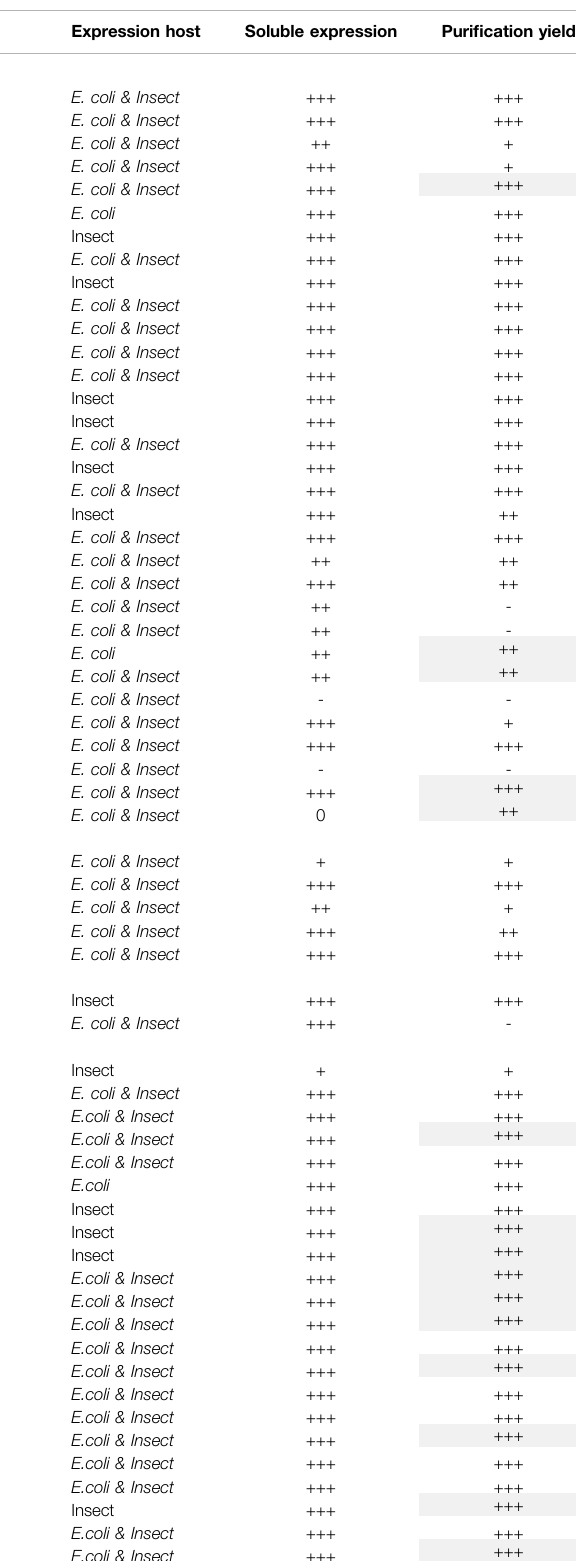
TABLE 1 | The bTB ORFs selected for recombinant expression tests.